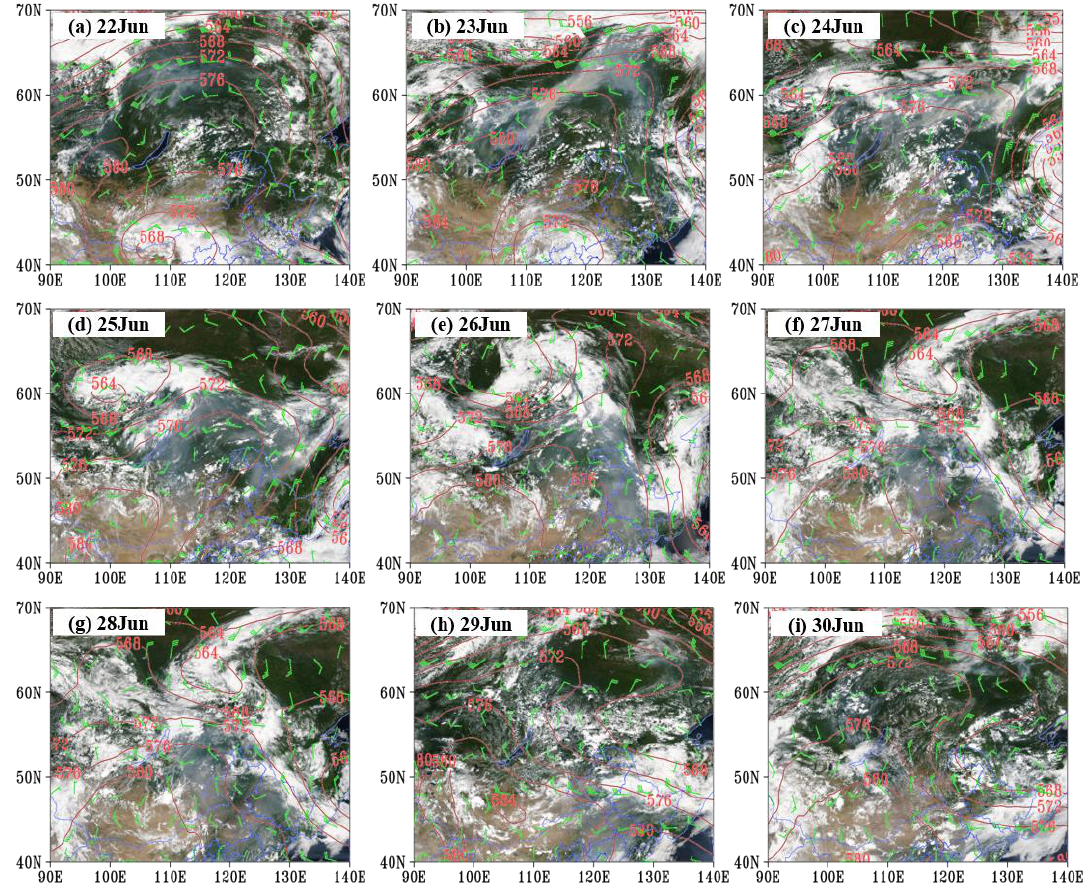
Figure 4. The geopotential height at 500 hPa and wind field at 700 hPa and Aqua MODIS daytime true color images at 06:00 GMT from 22 June to 30 June 2017 in Northeast Asia.